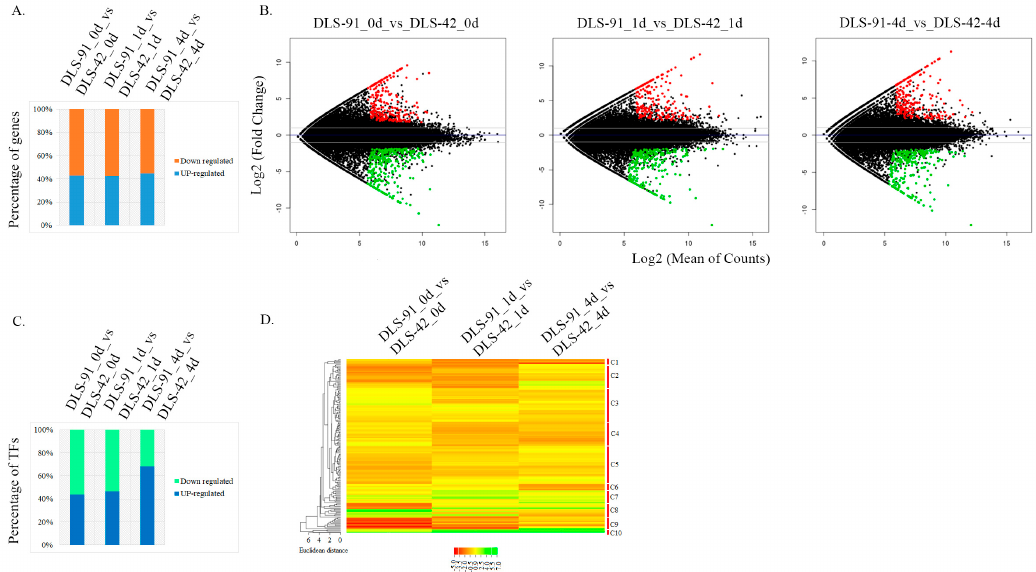
Figure 4. Identification of differentially expressed genes and transcription factors from the transcriptomes of DLS-42 and DLS-91 (0, 1, and 4 days of dark treatment). ( A ) Bar chart showing relative proportions of up- and downregulated genes. ( B ) MA plot of differentially expressed genes. The x-axis indicates log 2 (mean number of counts), and the y-axis corresponds to log 2 fold change. ( C ) Bar chart showing relative proportions of up- and downregulated transcription factors. ( D ) Heat map of differentially expressed transcription factors identified from the transcriptome data. The transcription factors are arranged according to their positions in the cladogram.